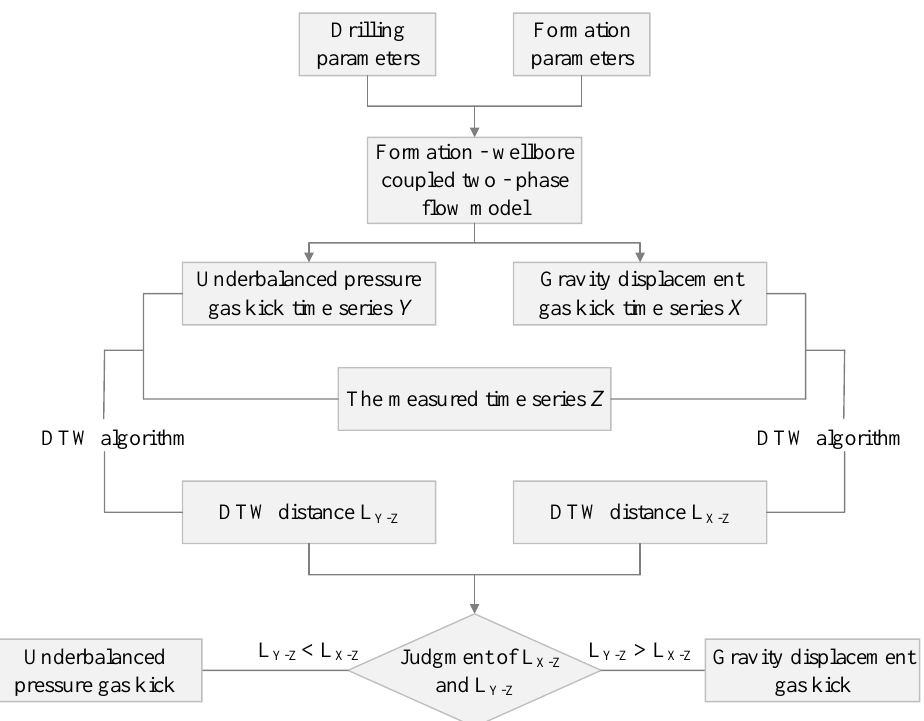
Figure 8. Flow of the gas kick type identification, based on DTW.